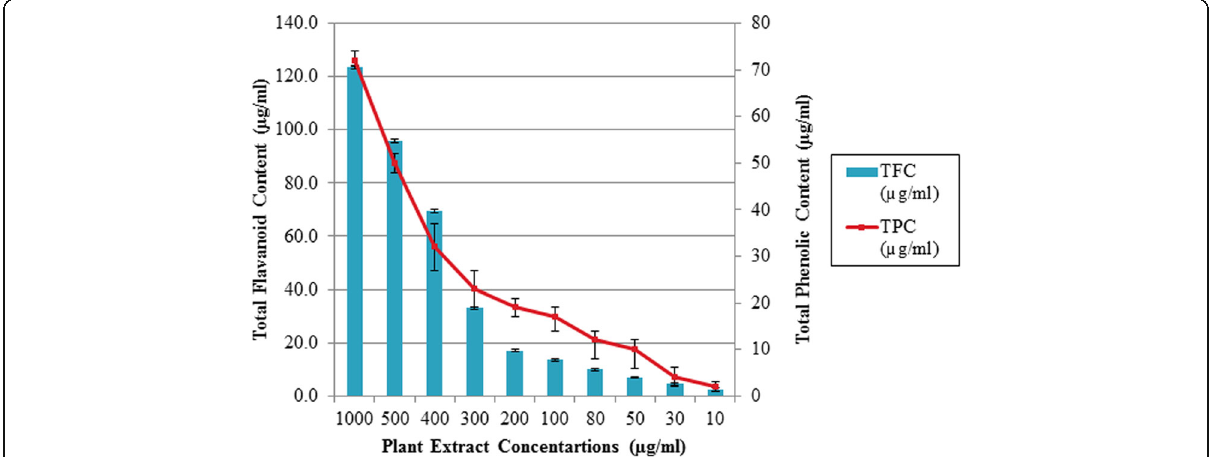
Fig. 1 Total phenolic contents and total flavanoids content determined in the leaves extract of B. pilosa . Bar represents the means ± SD of triplicate